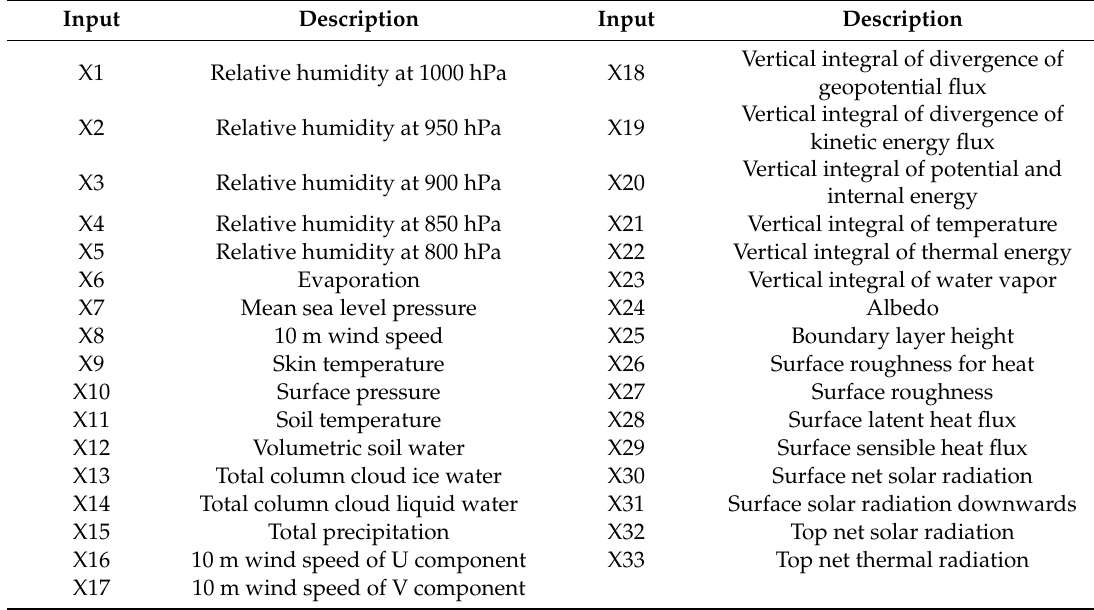
Table 1. Neural networks model